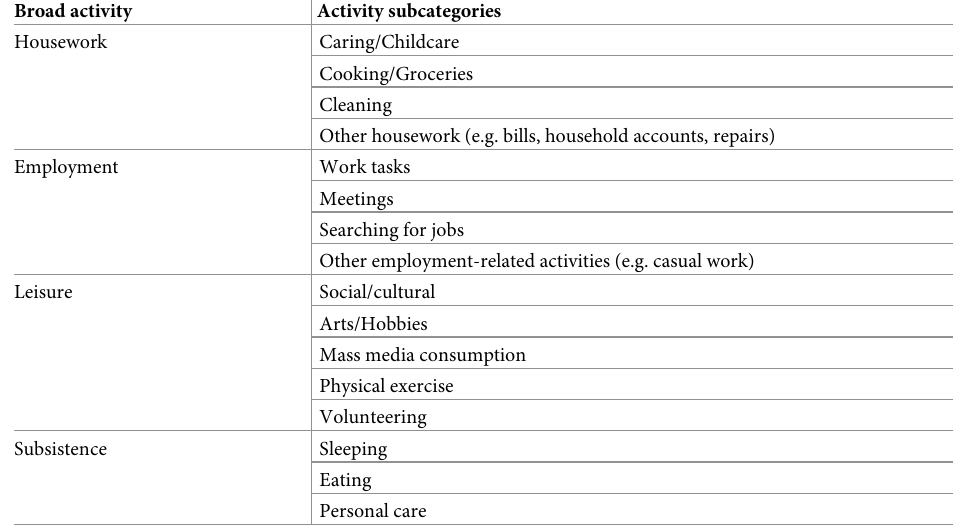
Table 1. Time use diaries: Mapping between activity subcategories and the broad activity categories used in our analysis. Broad